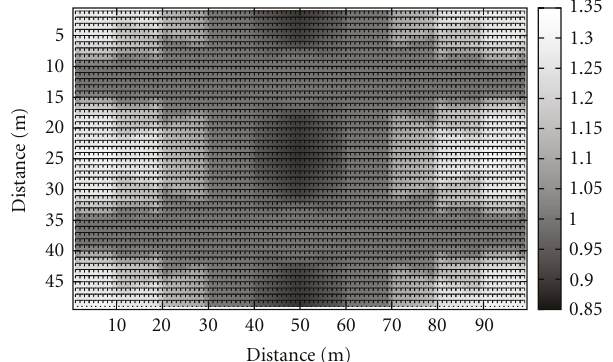
Figure 8: User throughput achieved for cooperative relaying in relation to direct transmission.